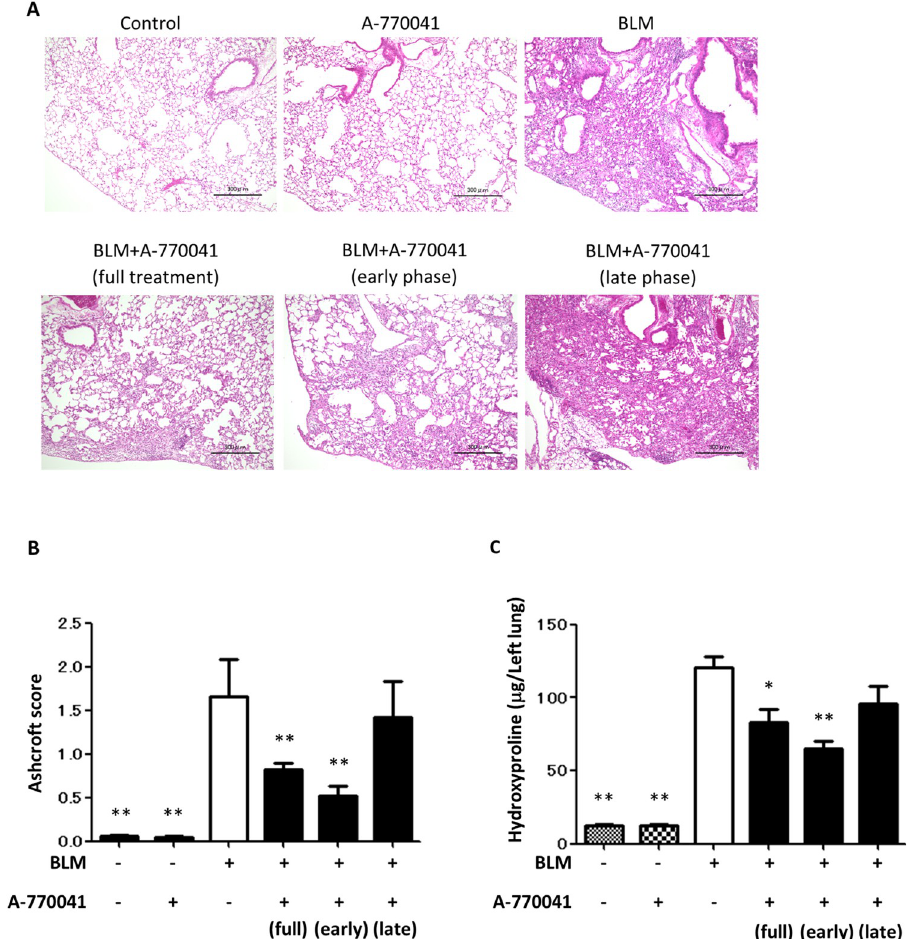
Fig 2. A-770041 attenuates BLM-induced lung fibrosis. Mice received a single transbronchial instillation of 3.0 mg/ kg BLM on Day 0, and A-770041 (5 mg/kg/d) or vehicle was administered daily. Mice were separately treated with A- 770041 from days 0 to 10 (early phase), days 11 to 21 (late phase) or days 0 to 21 (full treatment). On Day 21, mice were killed, and their lungs were collected. Lung sections were stained with (A) hematoxylin and eosin. (B) The fibrotic changes in the lungs were quantified with a numerical fibrotic score (Ashcroft score) histopathologically (n = 6). (C) The hydroxyproline contents in lung tissue were measured by a hydroxyproline assay (n = 6). � p < 0.05 versus groups treated with BLM without A-770041; �� p < 0.01 versus groups treated with BLM without A-770041. Flow-cytometry analyses revealed that the proportion of TGF- β -producing CD4 + T-cells increased from days 7 to 21 after BLM instillation (Fig 3B and 3E). The proportion of IL- 17-producing CD4 + T-cells was slightly increased on day 14 after BLM instillation, but not to a significant degree (Fig 3D).